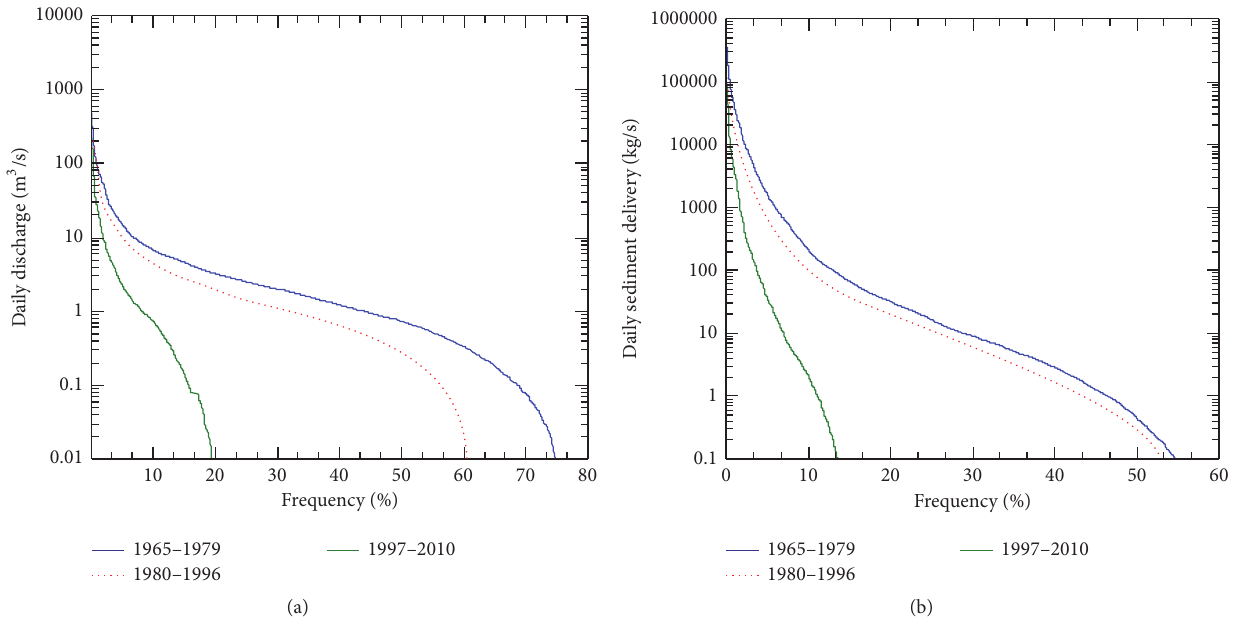
Figure 5: Flow duration curves of daily runoff (a) and sediment delivery (b) at Huangfu